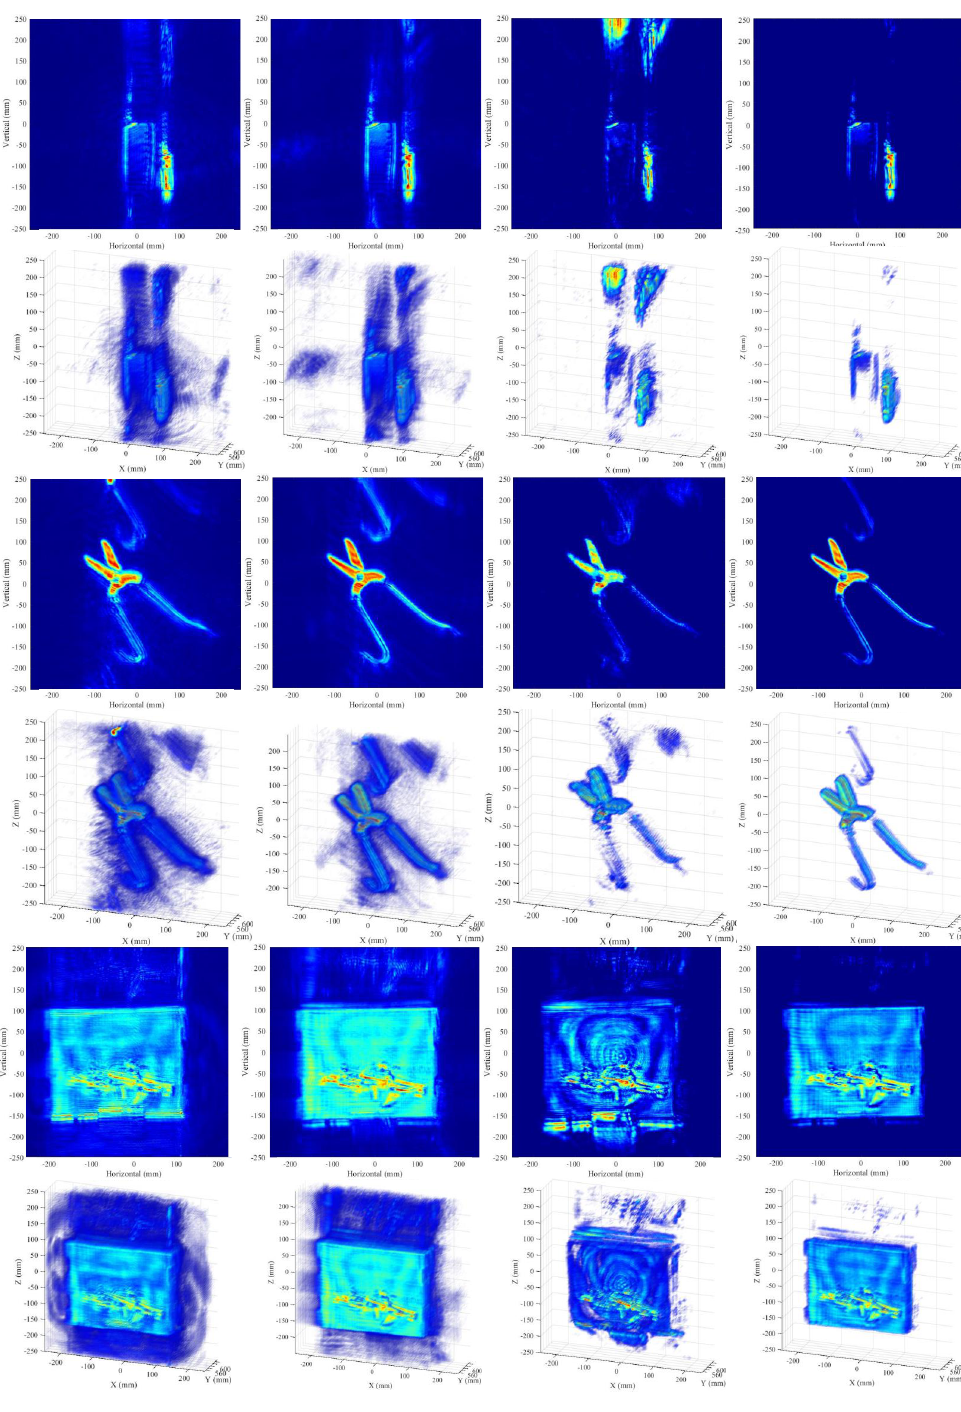
Figure 14. Imaging results of different targets using different algorithms. (Rows 1, 2) are the results of knives; (Rows 3, 4) are the results of snips; (Rows 5, 6) are the results of the concealed rifle. Rows 1,3, and 5 are the 2-D imaging results; Rows 2,4, and 6 are the 3-D imaging results; Column 1 is the BPA imaging results; Column 2 is the RMA imaging results; Column 3 is the CSA imaging results; Column 4 is the RMIST-Net imaging